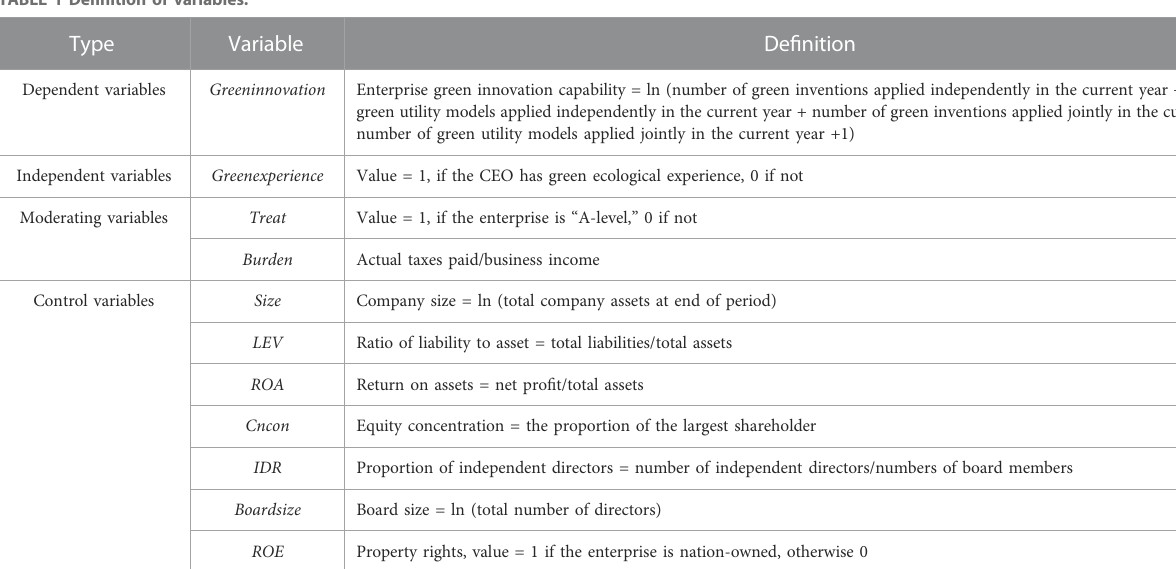
TABLE 1 De fi nition of